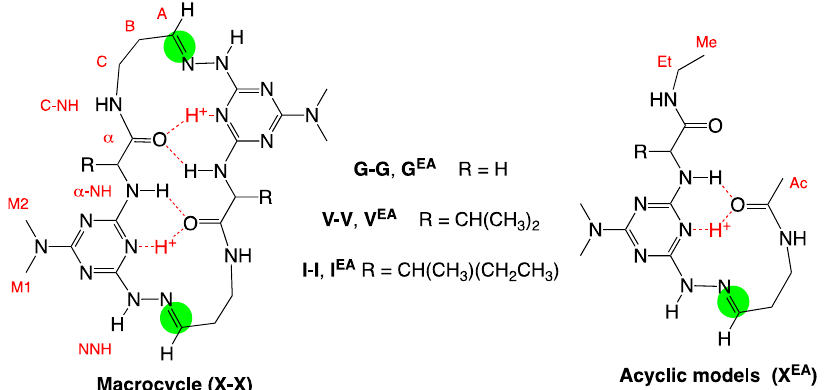
Chart 1. Molecules described in this study. NMR labels are indicated. The X-ray structure used a morpholine derivative of the molecule shown, wherein the dimethylamine group was replaced to promote crystallization.